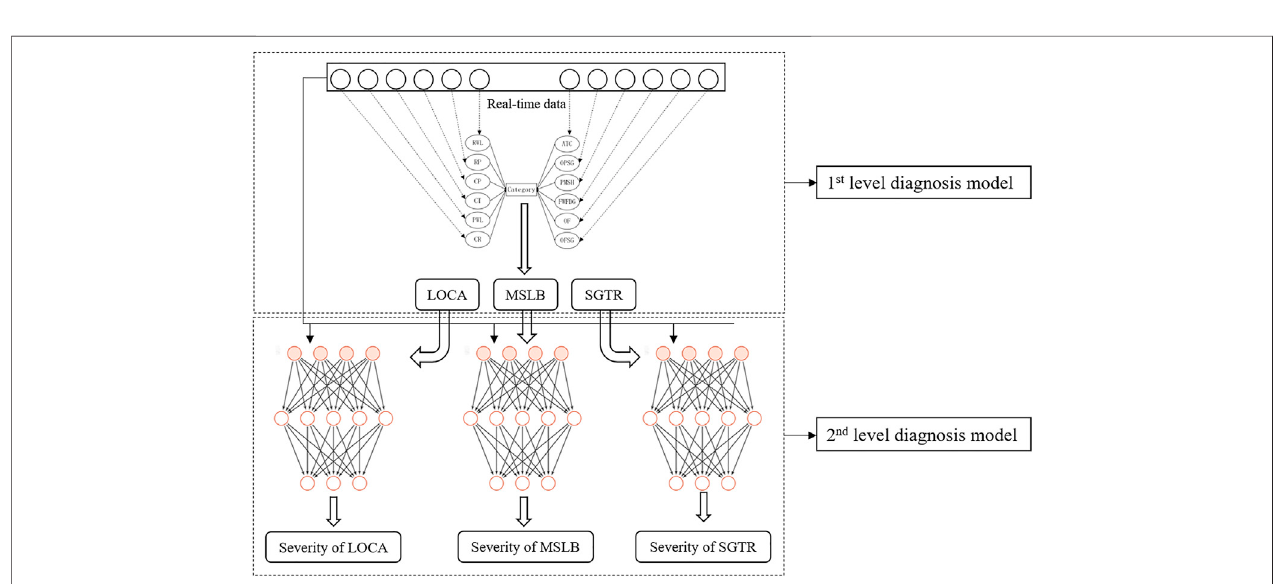
FIGURE 7 | SBN-ANN graded diagnosis process.